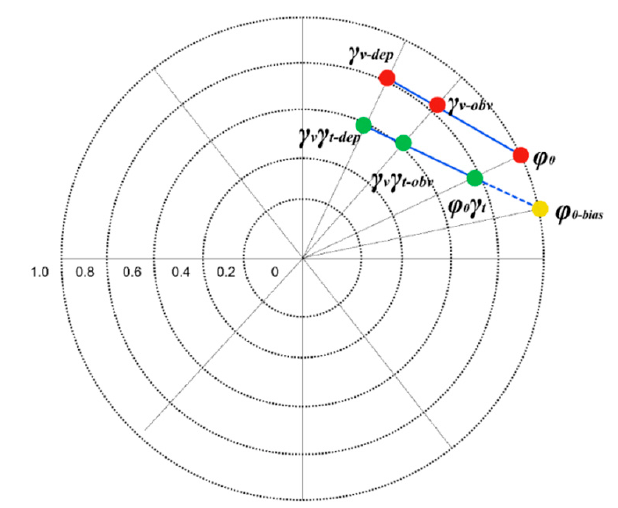
Figure 3. Plot illustrating the principle of penetration depth correction for RVoG model errors.